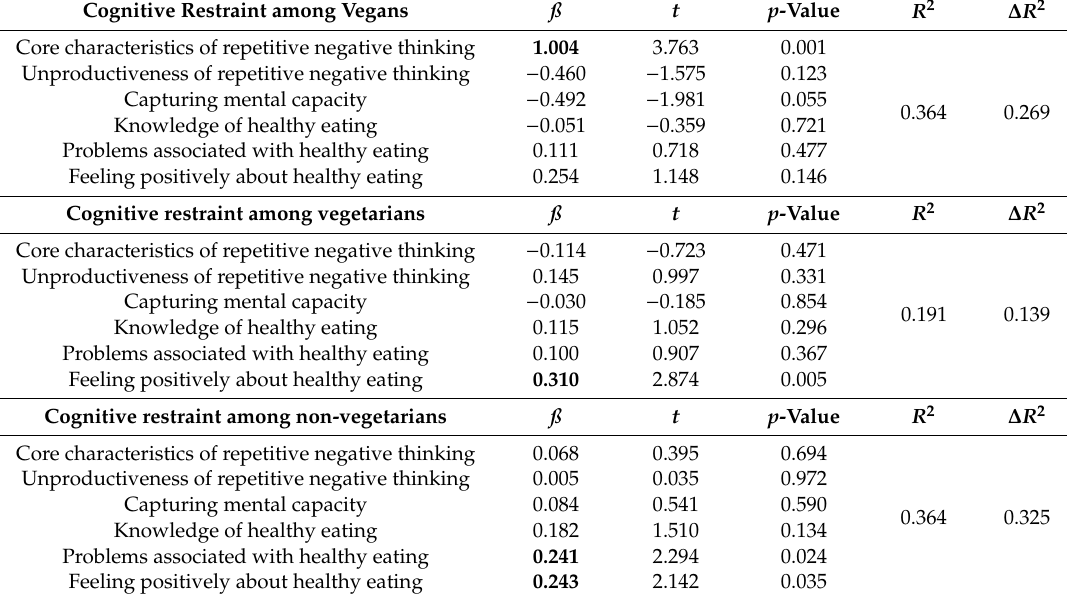
Table 6. Determinants of cognitive restraint in adults with varying dietary